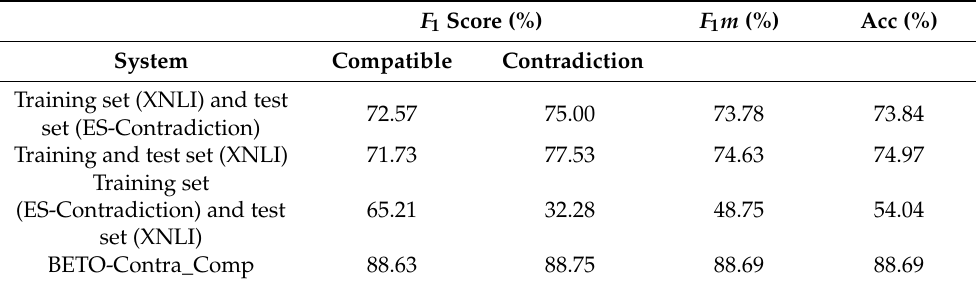
Table 7. Results obtained from Experiment 5: Results of different training-test configurations between XNLI and ES-Contradiction.